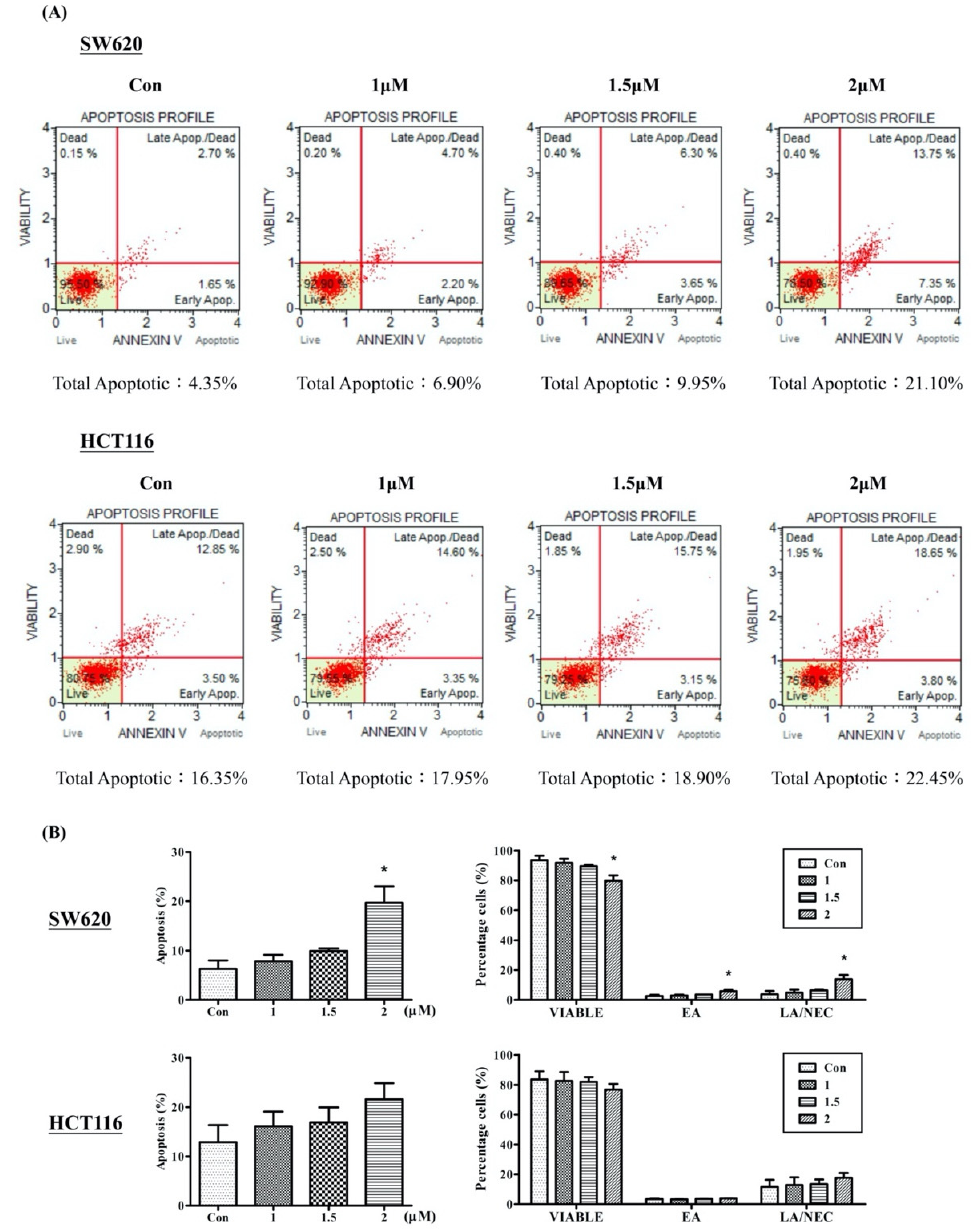
Figure 6. Annexin V/FITC Assay: ( A ) dot plot of Annexin V/FITC in SW620 and HCT116 cells after treatment with Arylquin 1; ( B ) quantification of Annexin V/FITC in SW620 and HCT116 cells. EA—early apoptosis; LA/NEC—late apoptosis/necrosis. All data are expressed as mean ± SEM. * p < 0.05 compared with corresponding controls.